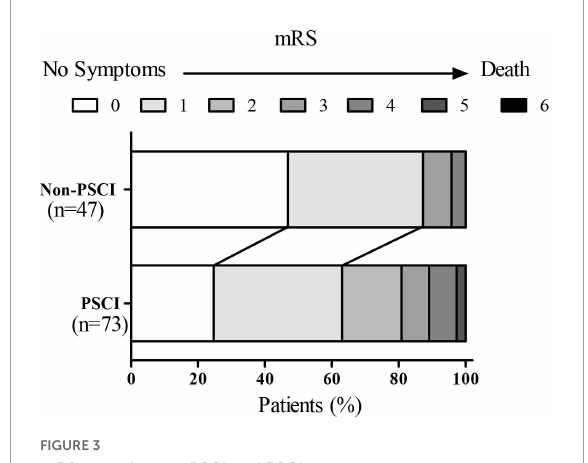
FIGURE3 mRS score in non-PSCI and PSCI groups.